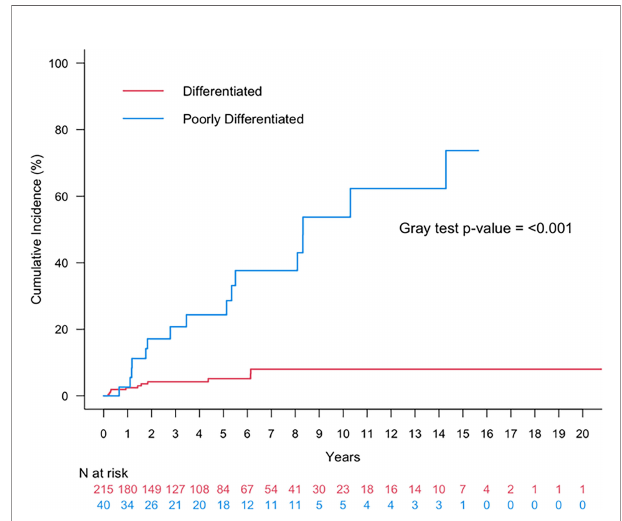
FIGURE 5 | Cumulative incidence of any recurrence (local, regional, distant) or death for patients with oncocytic papillary thyroid carcinoma (red) or oncocytic poorly differentiated thyroid carcinoma (blue).